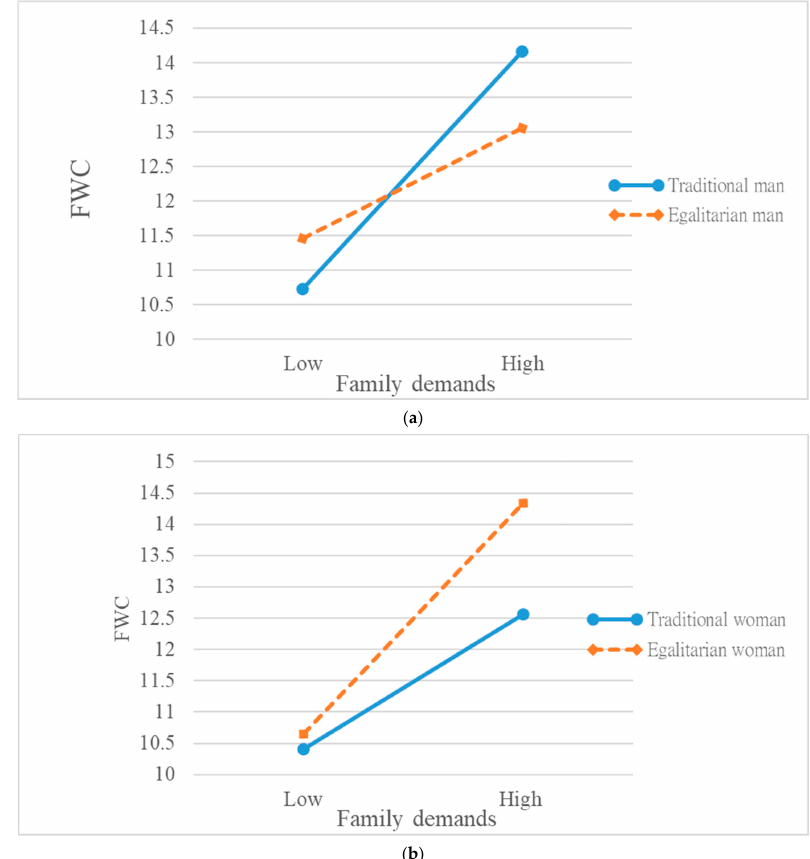
Figure 2. ( a ) . Interactive effect of gender role orientation and family demands on family-to-work conflict (for men). ( b ) Interactive effect of gender role orientation and family demands on family-to-work conflict (for women). In testing for H3 and H4 (gender as a moderator on the role demands–FWC relation- ship within the egalitarian group), we used the median score for the gender role orienta- tion to split the sample into the egalitarian group and the traditional group. The same protocol for moderated regression was then followed. As our hypotheses relate only to the egalitarian group, the results for this group are reported in Table 5.